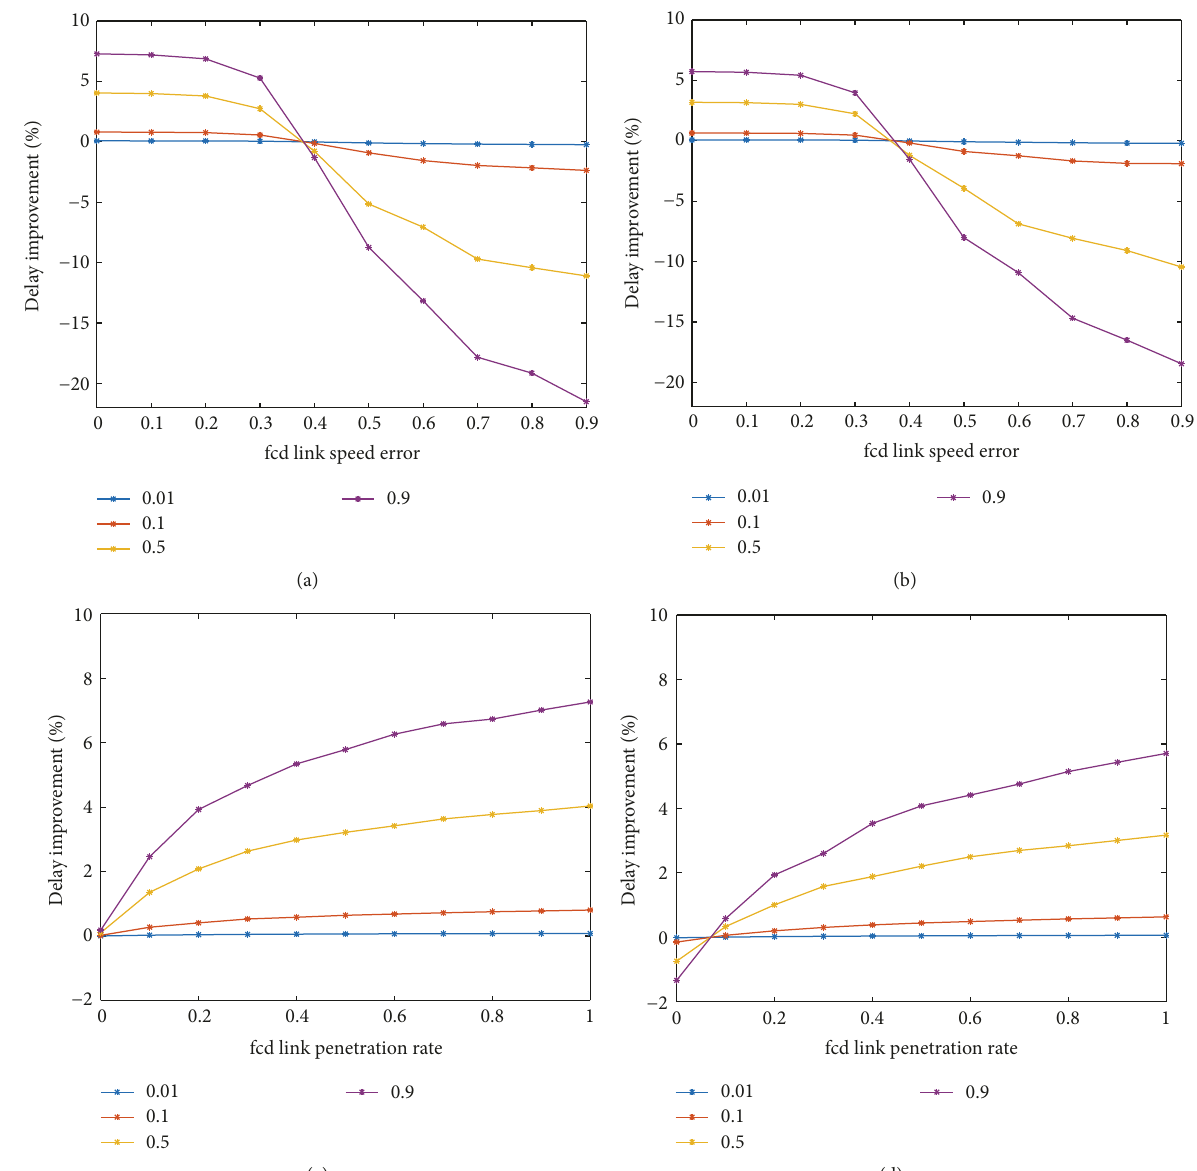
Figure 14: Delay improvement for 3 February 2016 (day with a lot of congestion) as percentage with regard to the normal delay: variation in link penetration with best route advice (a), variation in link penetration with top 3-route advice (b), variation in speed accuracy with best route advice (c), and variation in speed accuracy with top 3-route advice